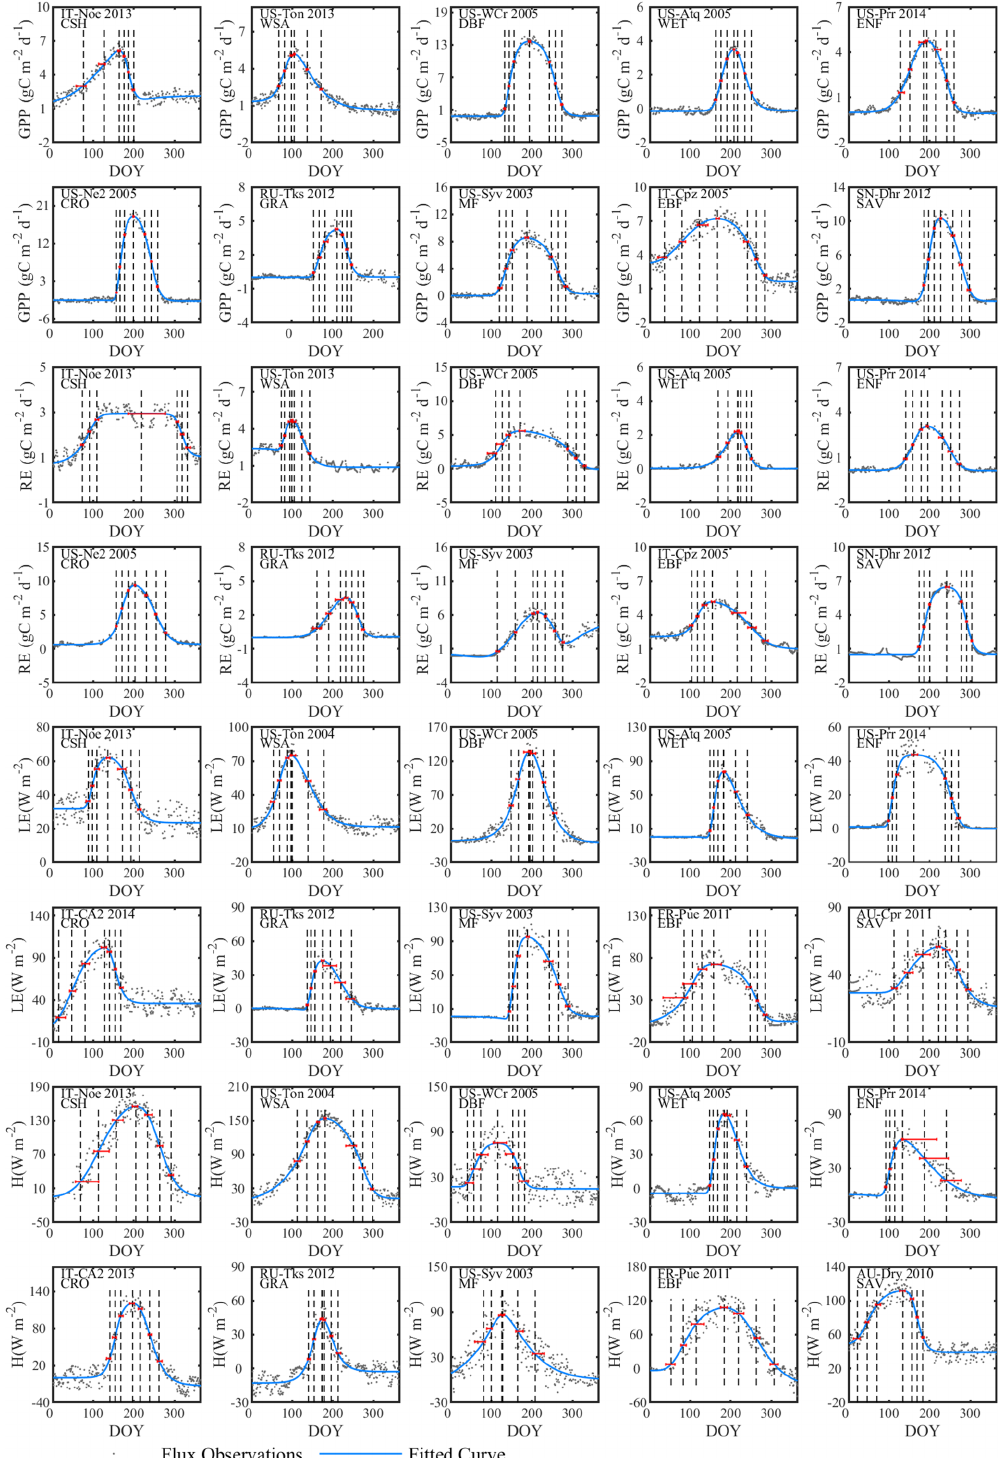
Figure 3. Examples of the seasonal dynamics of different fluxes for 10 sites representative of different biomes. One biome, open shrubland, was left off because of space limitations on a single page. The blue line indicates the double-logistic model (Eq. 1) fitted to the observed flux time series (black dots). The phenological transition points are marked with the vertical dashed lines, and the bootstrap estimates of 90% confidence intervals of these metrics are indicated with the horizontal red error bar for corresponding transition points. Note that the confidence intervals are not always symmetrical to the best